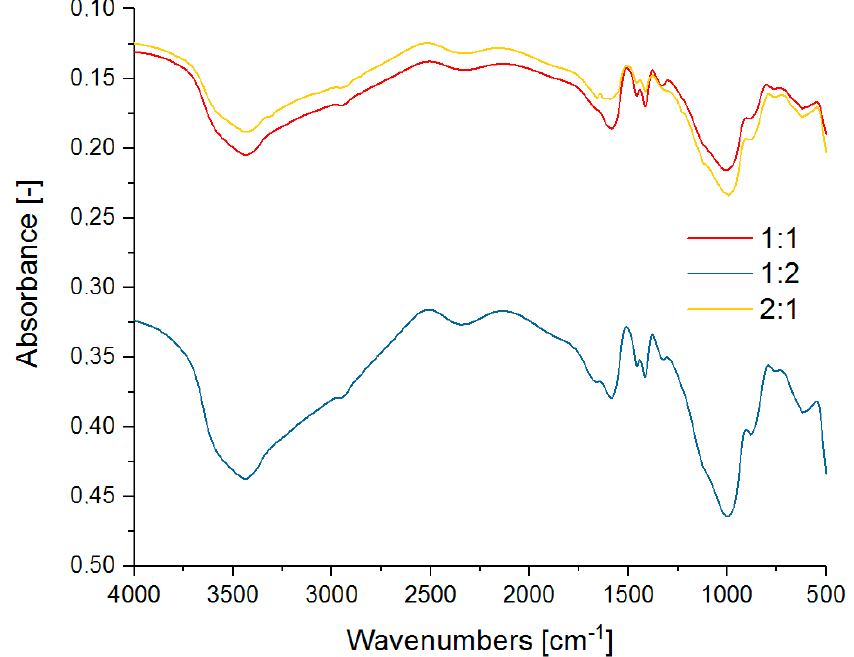
Figure 4. MIR spectra of the selected polymer-silicate hydrogels with the mass ratio 1:1, 1:2 and 2:1 of the sodium water glass to the sodium polyacrylate.